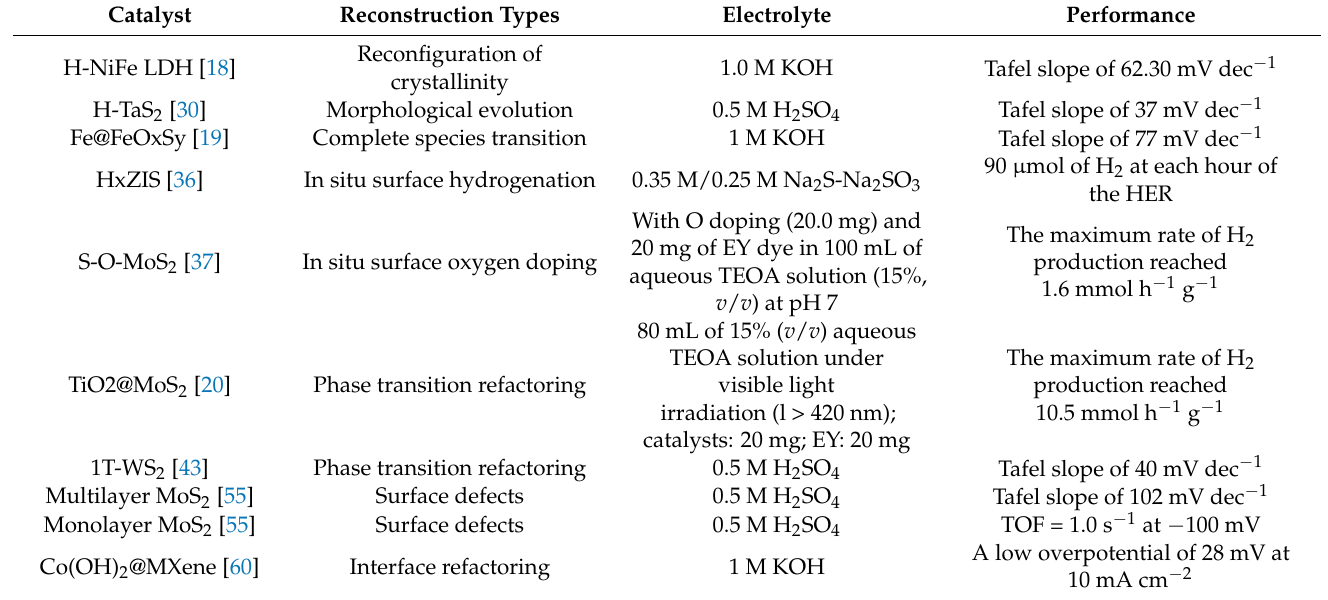
Table 1. Catalytic performance of electrocatalysts modulated via in situ surface